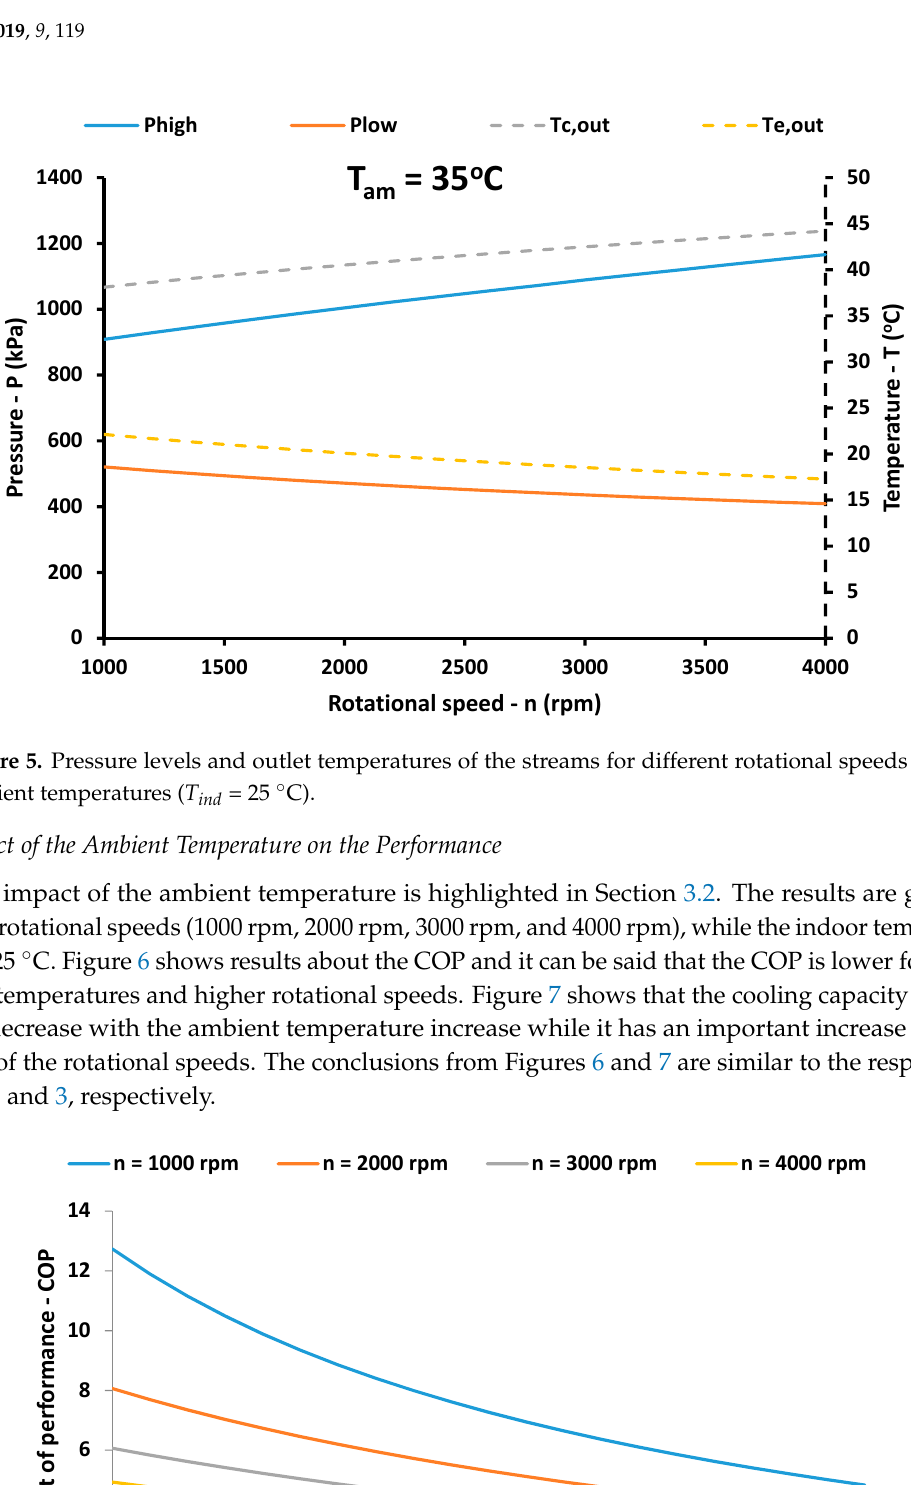
Figure 4. Compressor pressure ratio for different rotational speeds and ambient temperatures ( T ind = 25 °C).